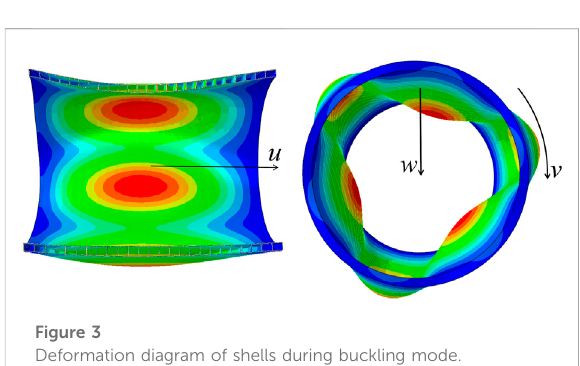
Figure 3 Deformation diagram of shells during buckling